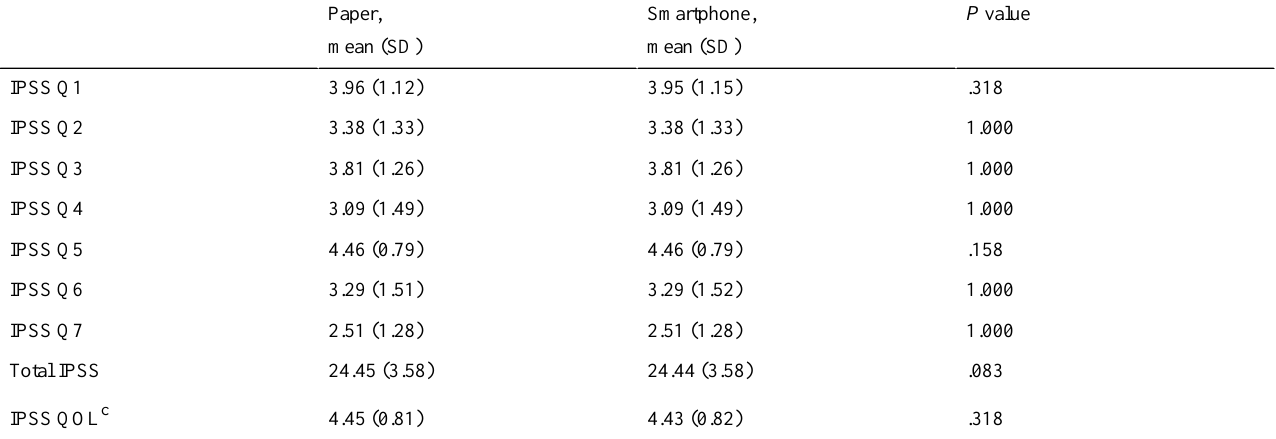
Table 5. Paired t test between paper and smartphone IPSS a in severe LUTS b